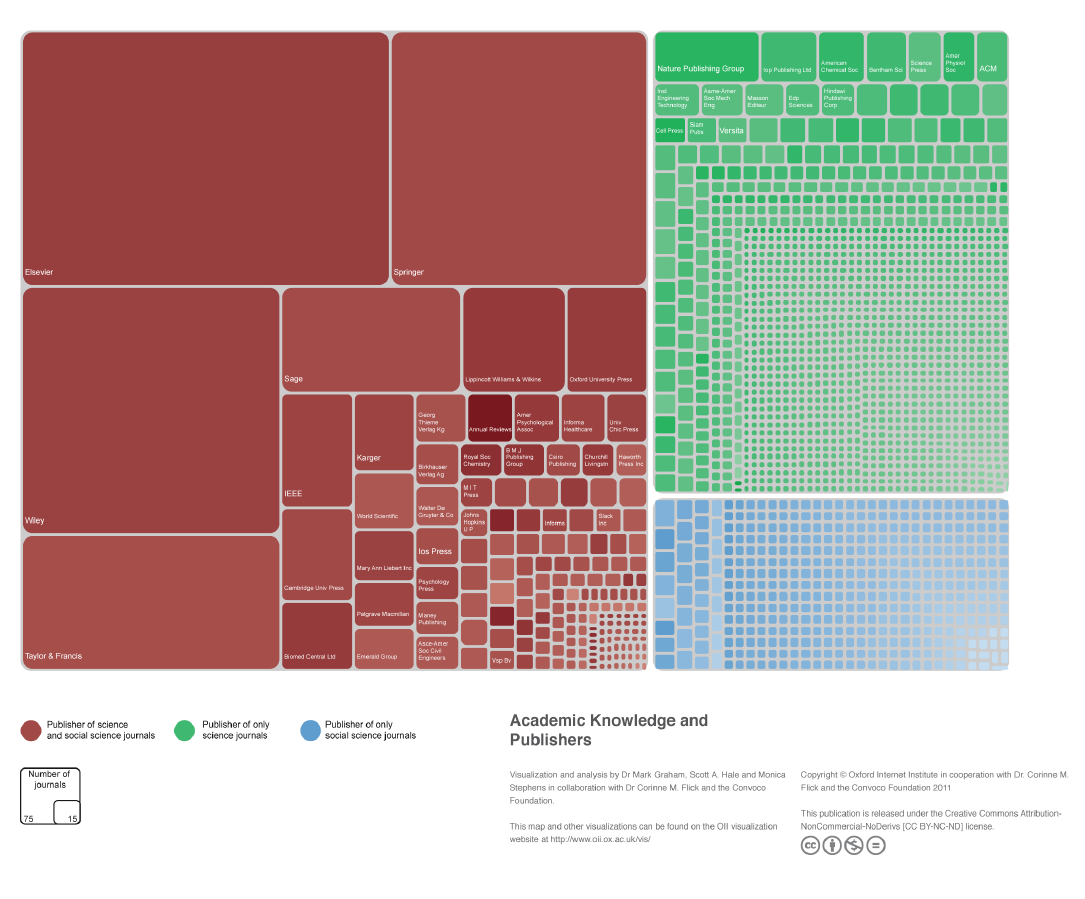
Figure 2: Academic knowledge and publishers Source: Graham et al. 2011: